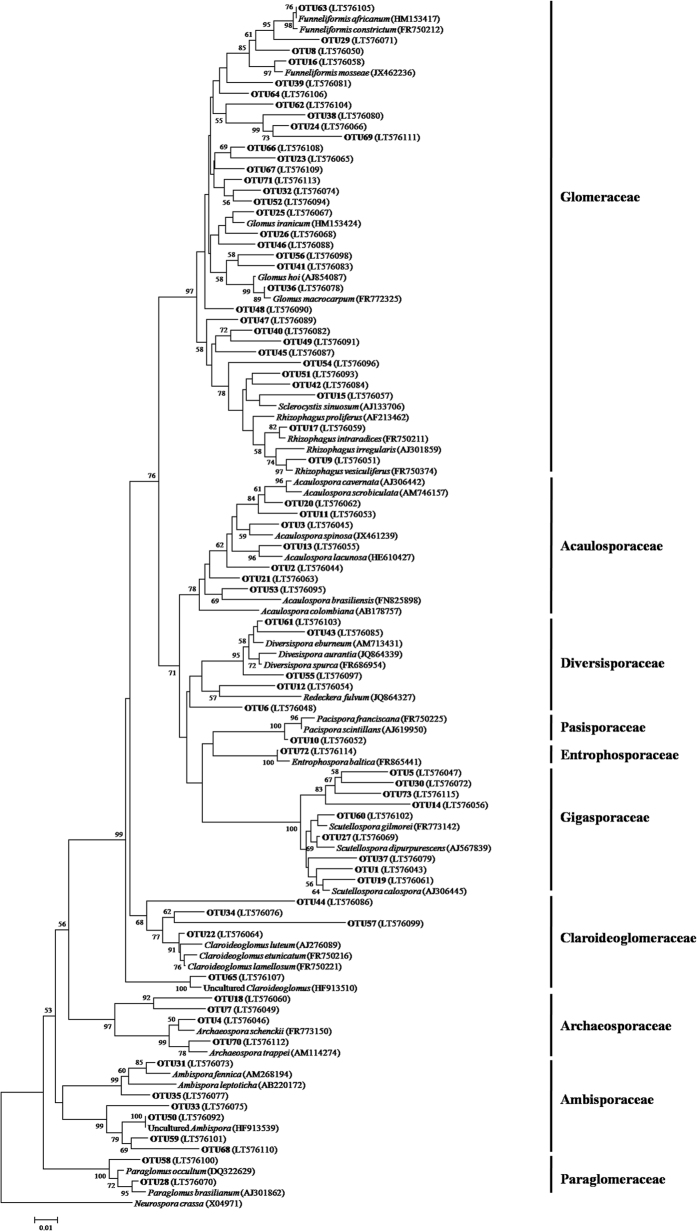
Neighbor-joining tree of arbuscular mycorrhizal (AM) fungi.The 18S rDNA sequences (ca. 400 bp) of AM fungal OTUs obtained in this study and the references downloaded from GenBank were shown concomitantly by the corresponding accession numbers (parentheses). Bootstrap values were calculated on the basis of 1,000 data resampling (>50% of the values are shown). Neurospora crassa was used as an outgroup. Scale bar represents 1% sequence divergence.